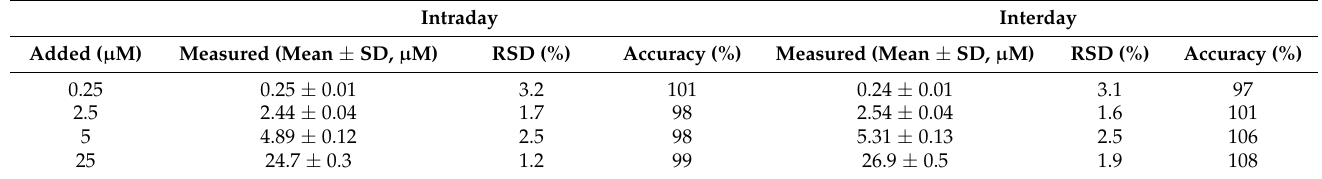
Figure 2. Chromatograms of ( a ) ribavirin standard, ( b ) serum sample after purification with MonoSpin PBA. Table 1. Intra- and inter-day precision and accuracy in spiked serum samples ( n =